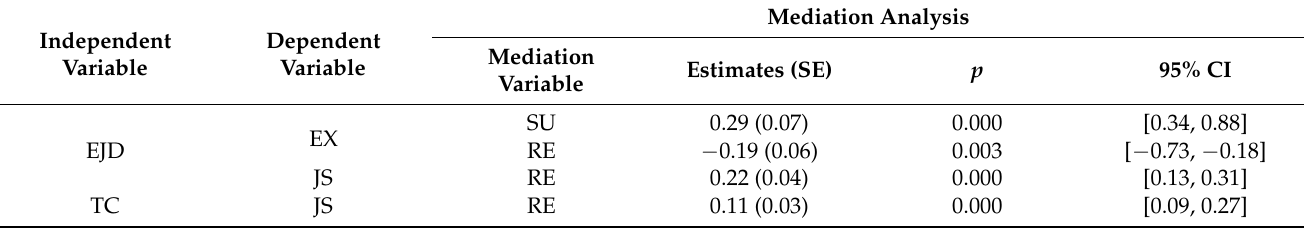
Table 2. Mediation of emotional regulation strategies on the relationship between job characteristics and principals’